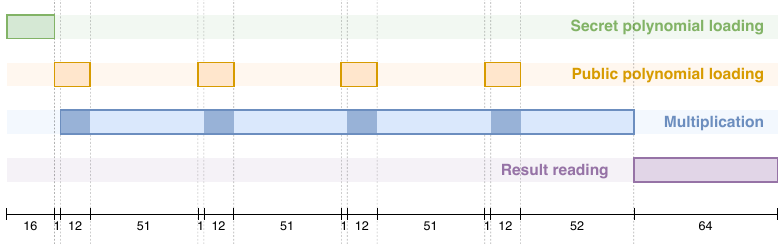
Figure 6: Timeline of polynomial multiplication when the public polynomial has 13 bit coefficients, from input loading to output reading. Darker blue areas denote when the multiplier reads coefficients from the loading data instead of the end of the